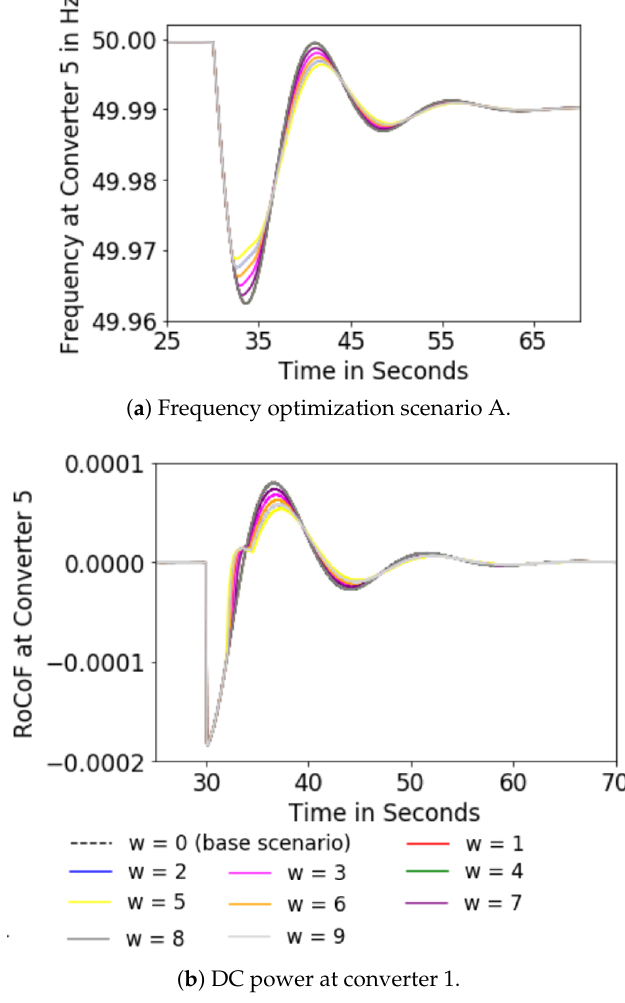
Figure 8. Frequency derivative/rate of change of frequency (RoCoF) scenario